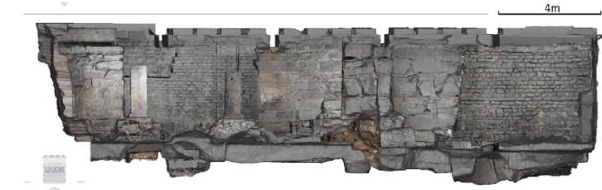
Figure 8. Example of a longitudinal sectional view extracted from the textured 3D model.